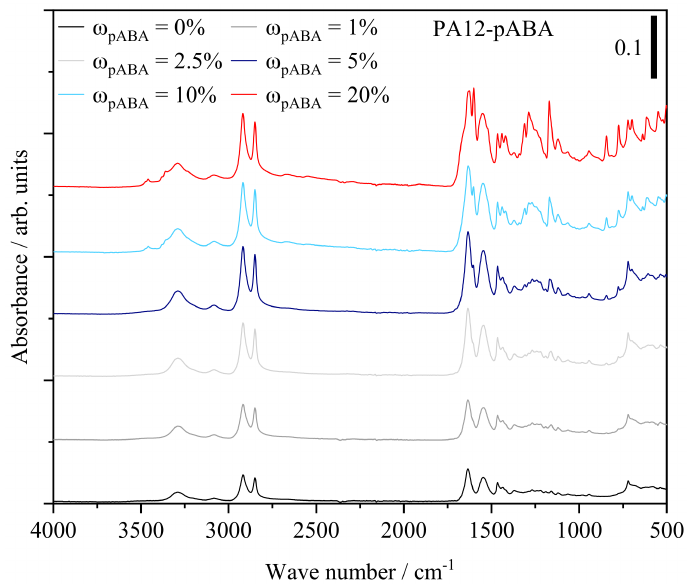
Figure 12. Overview of FTIR spectra of manufactured specimens in dependence on the fraction of pABA; adapted ordinate scaling.